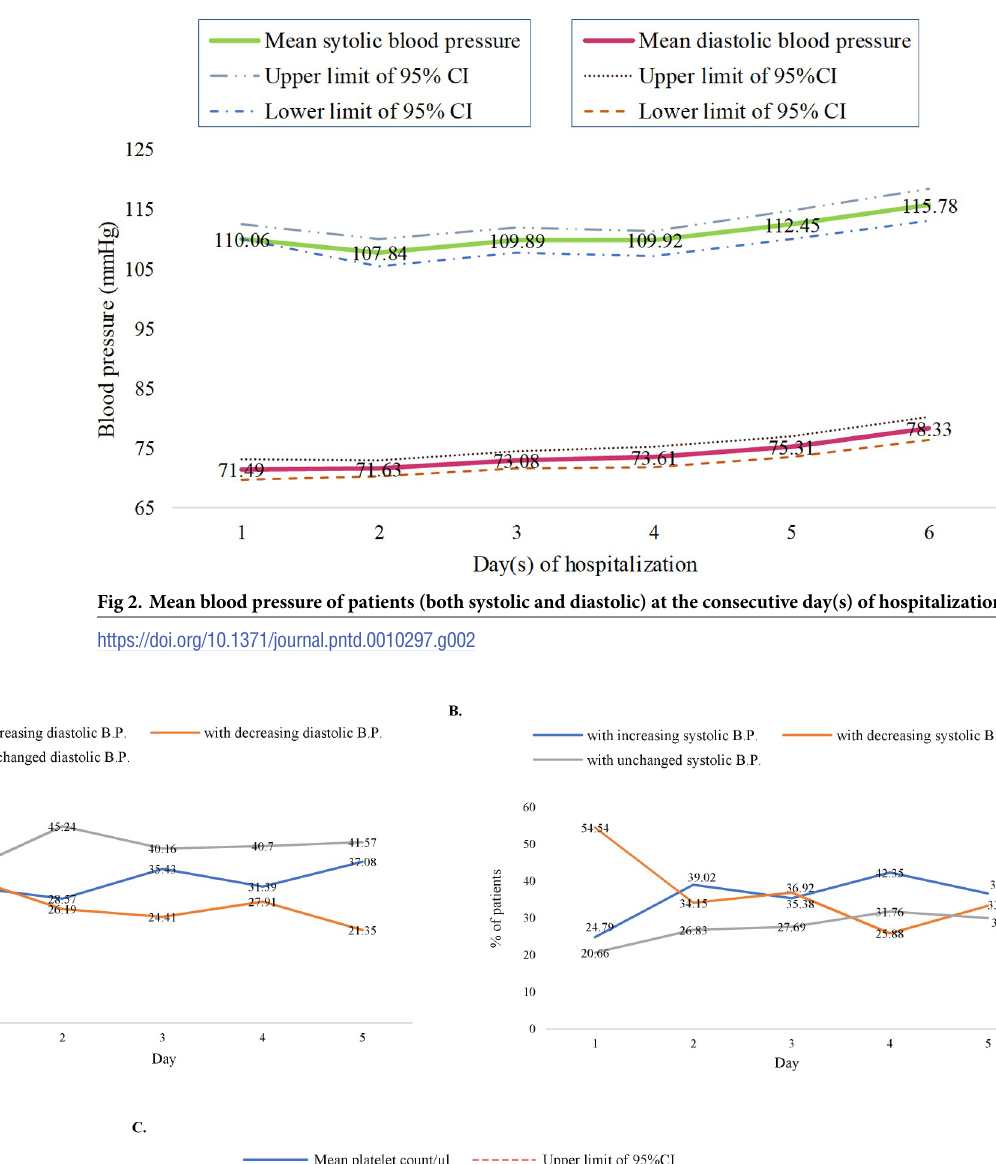
PLOS NeglectedTropical Diseases | https://doi.org/10.1371/journal.pntd.0010297 April 4,